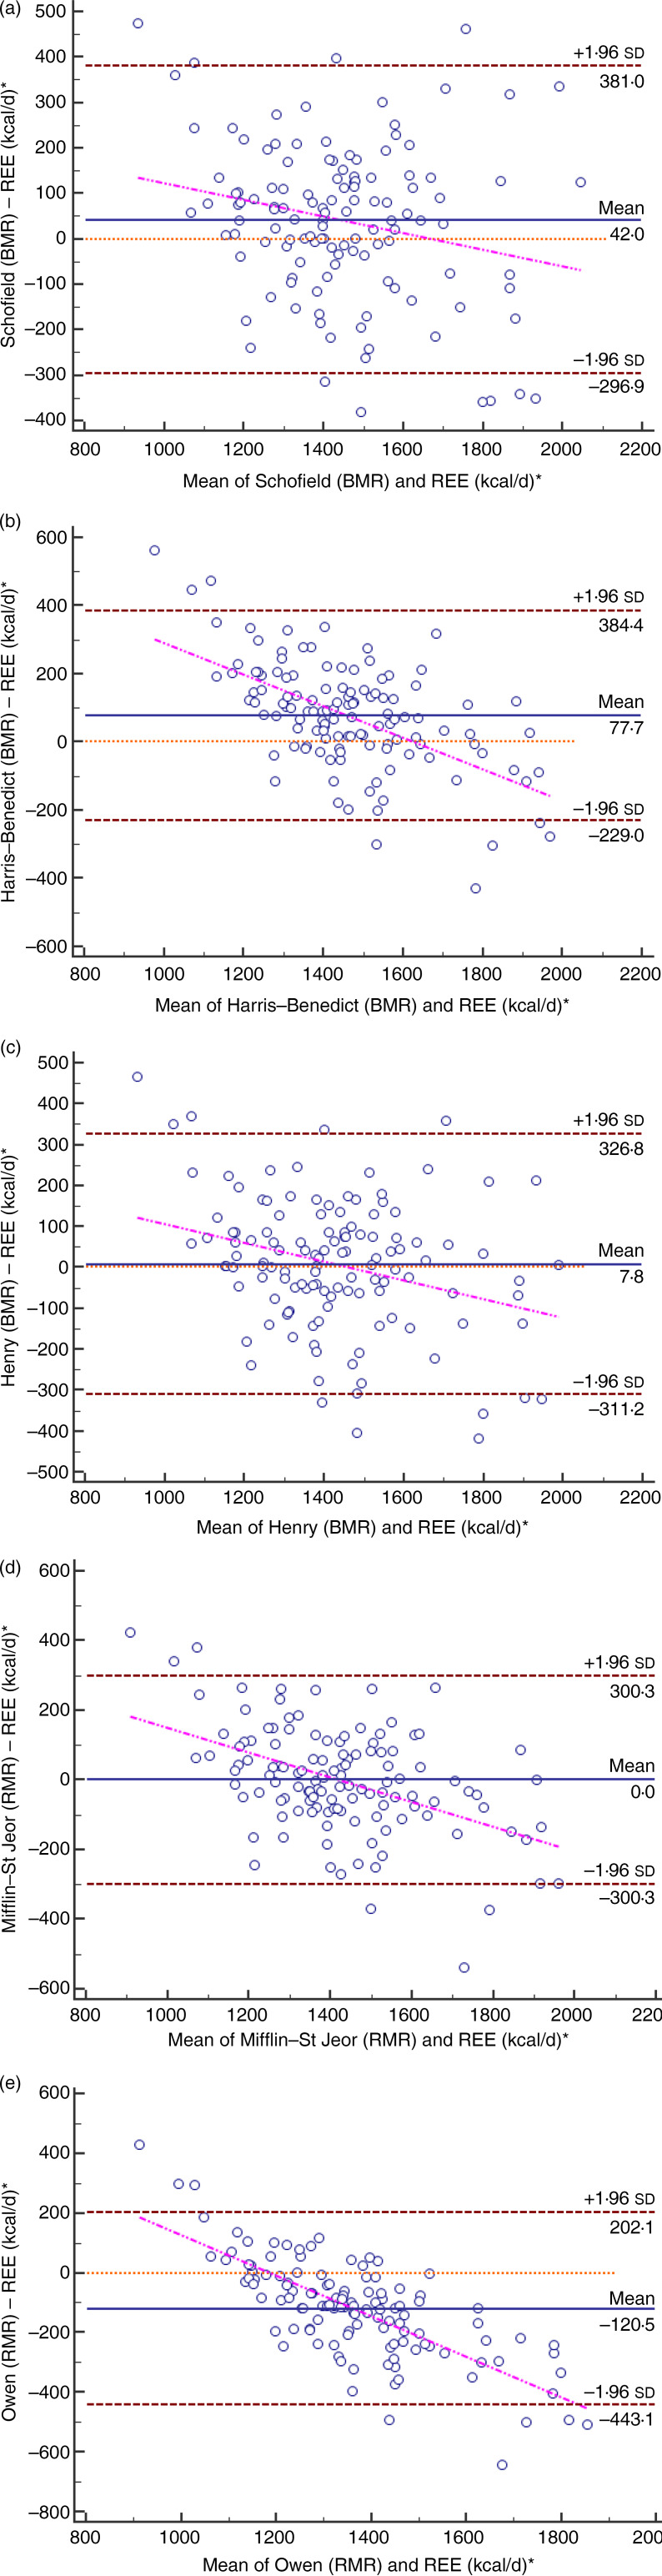
Bland–Altman plots of differences in RMR measured by indirect calorimetry and predicted using five different equations in 125 adult women. The solid line represents the mean difference (predicted – measured RMR). Upper and lower dashed lines represent the 95 % limits of agreement (±2 sd). The regression line indicates the difference between predicted and measured RMR, plotted against the mean. REE, resting energy expenditure. * To convert kcal to kJ, multiply by 4·184.